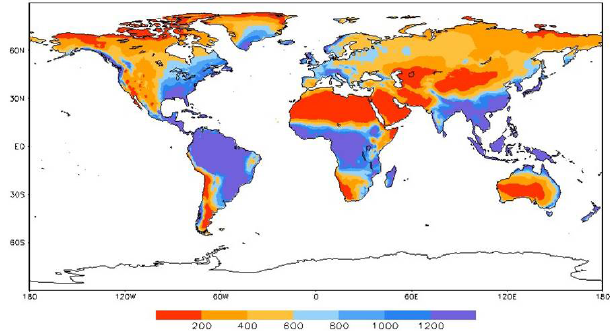
Fig. 1. Global distribution of annual mean precipitation from 1901 to 2009 (mmyr − 1 )